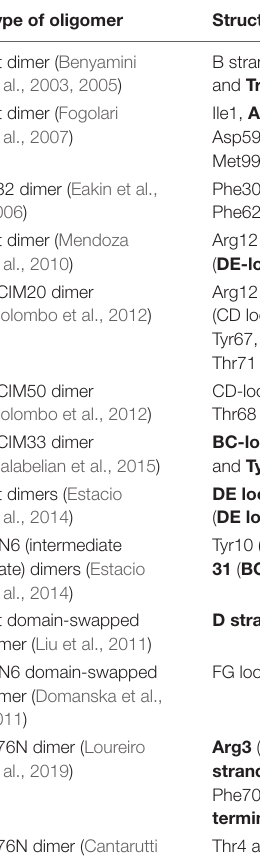
TABLE 3 | Interfacial regions and residues found in the interfaces of β 2m